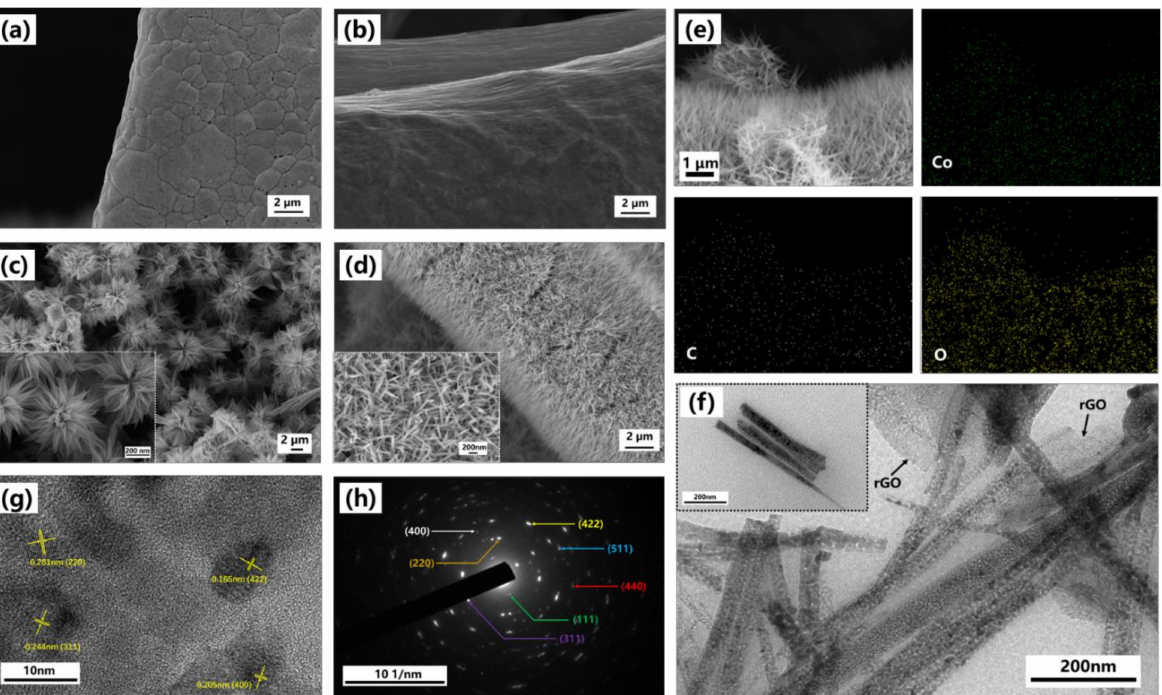
Figure 3. SEM images of ( a ) bare NF, ( b ) rGO/NF, ( c ) Co 3 O 4 /NF, and ( d ) Co 3 O 4 /rGO/NF (inset: Highly magnified images). ( e ) EDS elemental mapping images (Co, C, and O), ( f ) TEM (inset: The nano-needle shape of Co 3 O 4 ), and ( g , h ) corresponding HRTEM images and SAED pattern of the Co 3 O 4 /rGO/NF